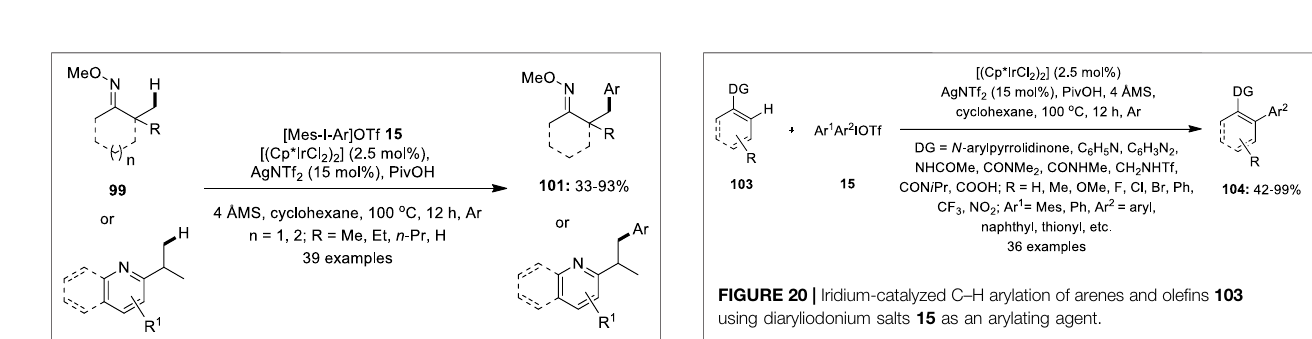
FIGURE 18 | Iridium-catalyzed three-component coupling of styrenes 94 with diaryliodonium salts 15 and heteroatom nucleophiles 95 .